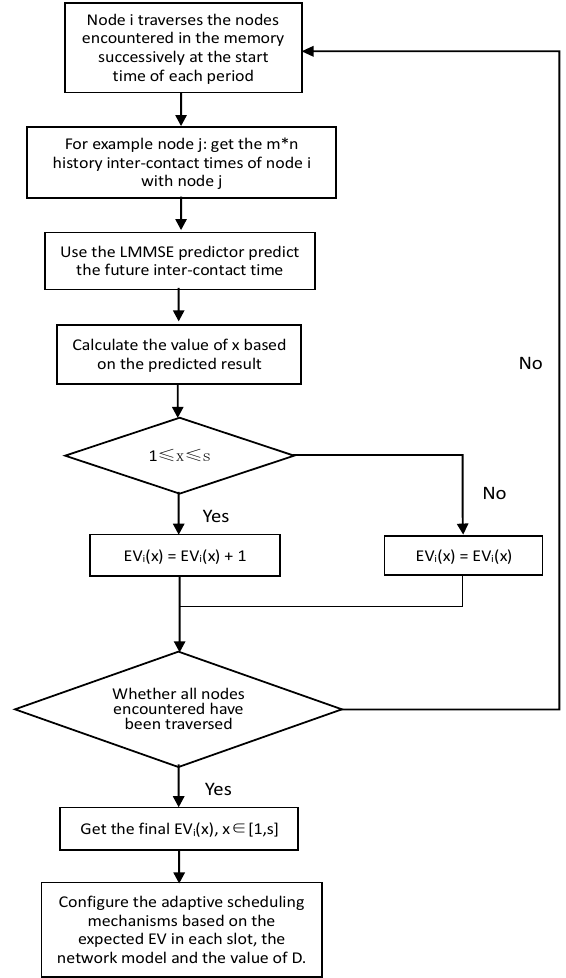
Figure 3. The flowchart of the ASMSS